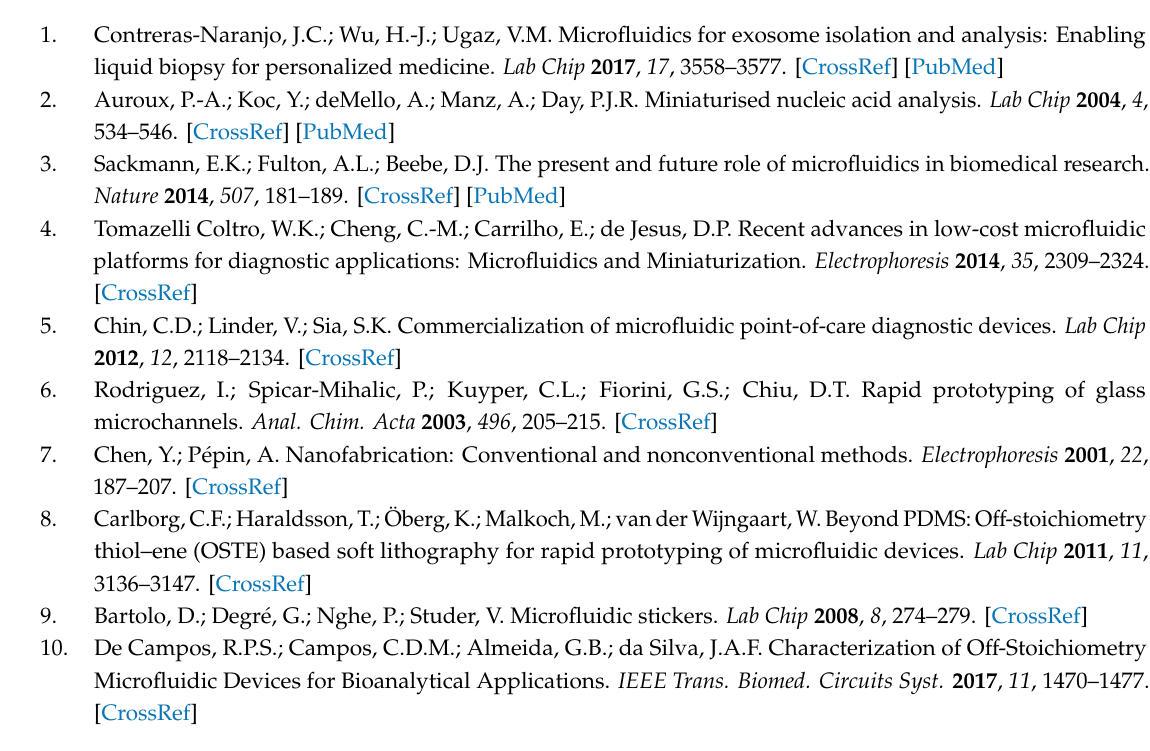
Table S1: Gold atoms characterized by EDS (energy dispersive spectroscopy) of OSTE surfaces either raw or treated (incubation and UV treatment) with gold nanoparticles. Plates were washed with ultra-pure water using ultrasound for 1 min before surface analysis (See experimental section for more details on experimental conditions), Figure S1: SEM micrography and XPS spectra of OSTE surfaces ((a) 2.5 thiol and (b) 1.3 allyl) after incubation with gold nanoparticles. Plates were washed with ultra-pure water using ultrasound for 1 min before surface characterizations (See experimental section for more details on experimental